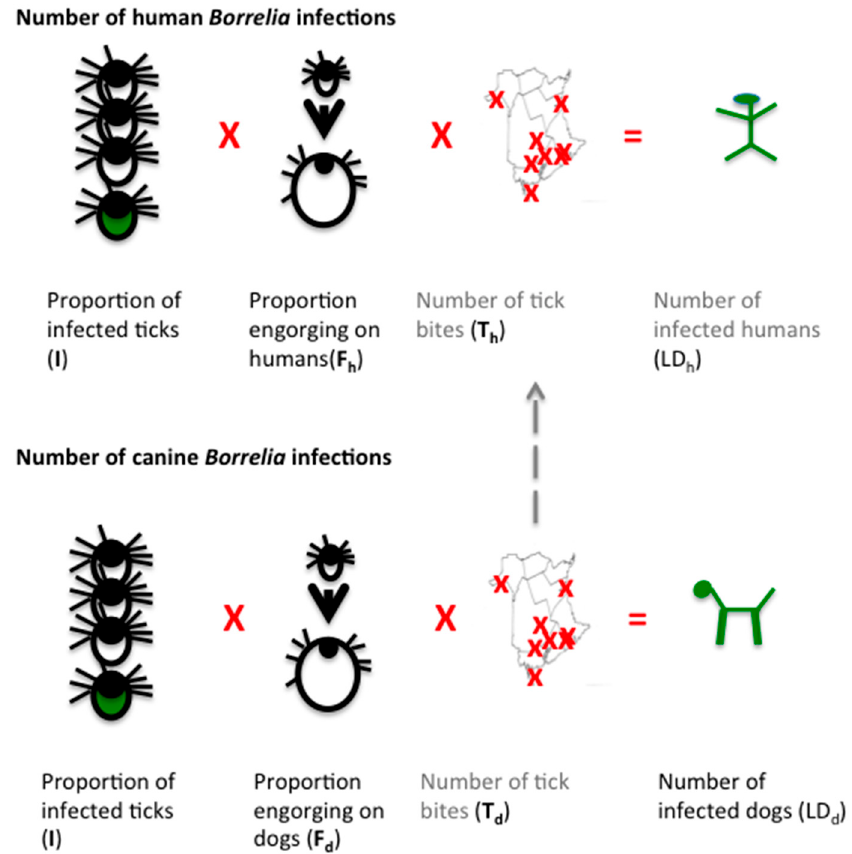
Figure 2. A schematic illustration of the algebraic logic underlying the calculation of human Lyme disease cases from canine sentinel data. Borrelia infection (green) requires the bite of an infected tick (green tick) ( I ) and engorgement of that tick for sufficient time to transmit infection (depicted as larger tick) ( F ). Multiplied by the number of tick bites indicated by crosses on a map ( T ), this gives the number of infected individuals ( LD ), depicted by green human and dog stick figures. Both dogs and humans acquire infection in the same manner. Known values (black text) are the proportion of infected tick, typical feeding time for each host and the number of infected dogs in NB. This allows calculation (calculated figures indicated in grey) of the number of tick bites required to produce that many infected dogs ( T d ). With adjustment for the relative exposure to ticks (dashed line), the predicted number of human tick bites ( T h ) can be calculated and so this formula allows calculation of the predicted number of infected humans (green stick figure) independently of human serological diagnosis and surveillance reporting.